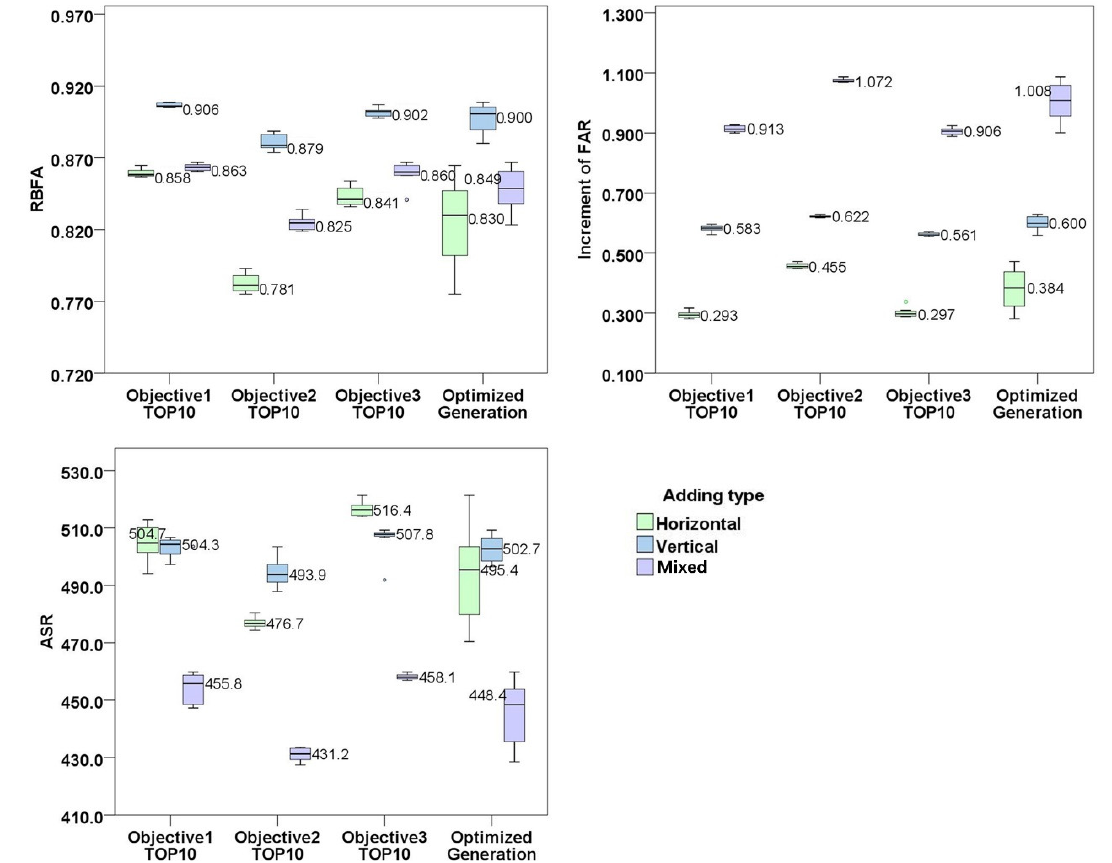
Figure 10. Objective values of the selected solutions for the three addition modes.